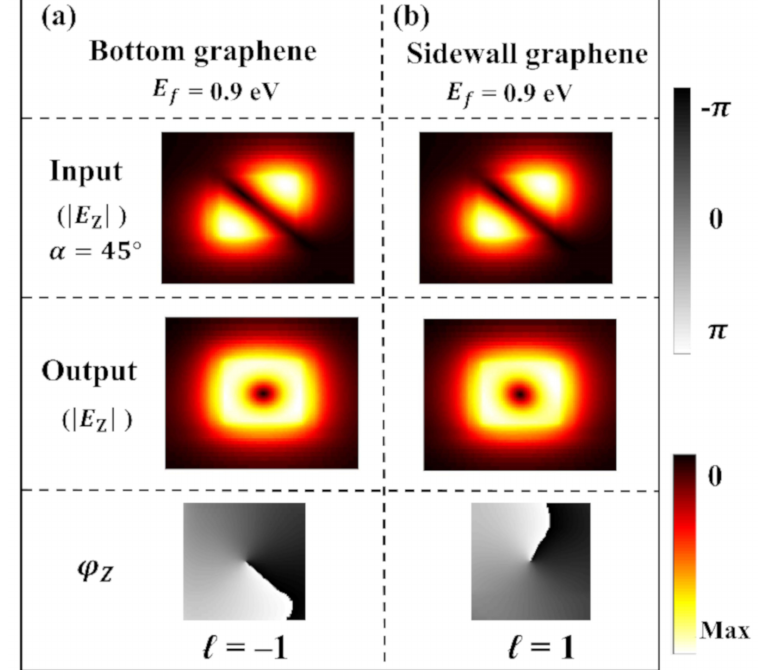
Figure 5. Longitudinal component of the electric fields ( | E Z | ) and their phase distributions ( ϕ Z ) for the input linearly polarized beam with α = 45 ◦ and the generated output vertex beams with switchable mode spirality when the Fermi level of bottom graphene is set with E f = 0.9 eV ( a ) and the Fermi level of sidewall graphene is set with E f = 0.9 eV ( b ).